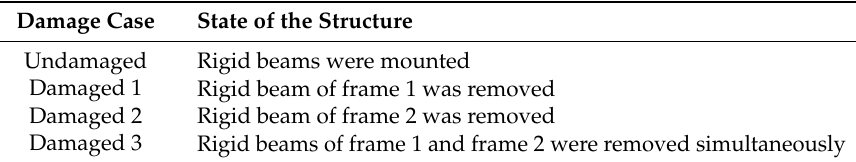
Table 1. Damage cases of the test used in this study.